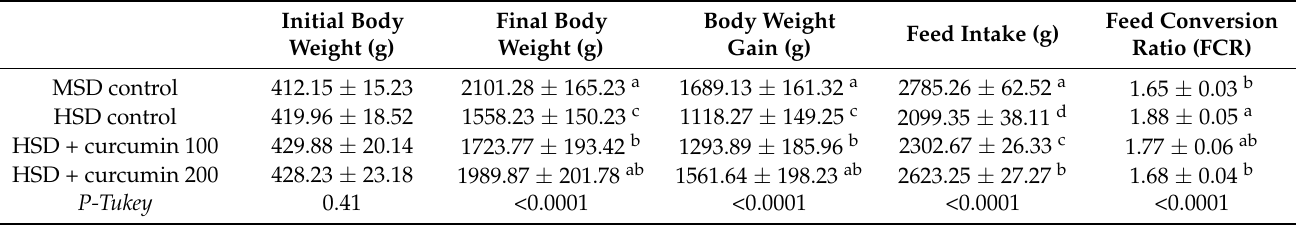
Table 4. Effect of curcumin on productive performance of broilers reared under high stocking